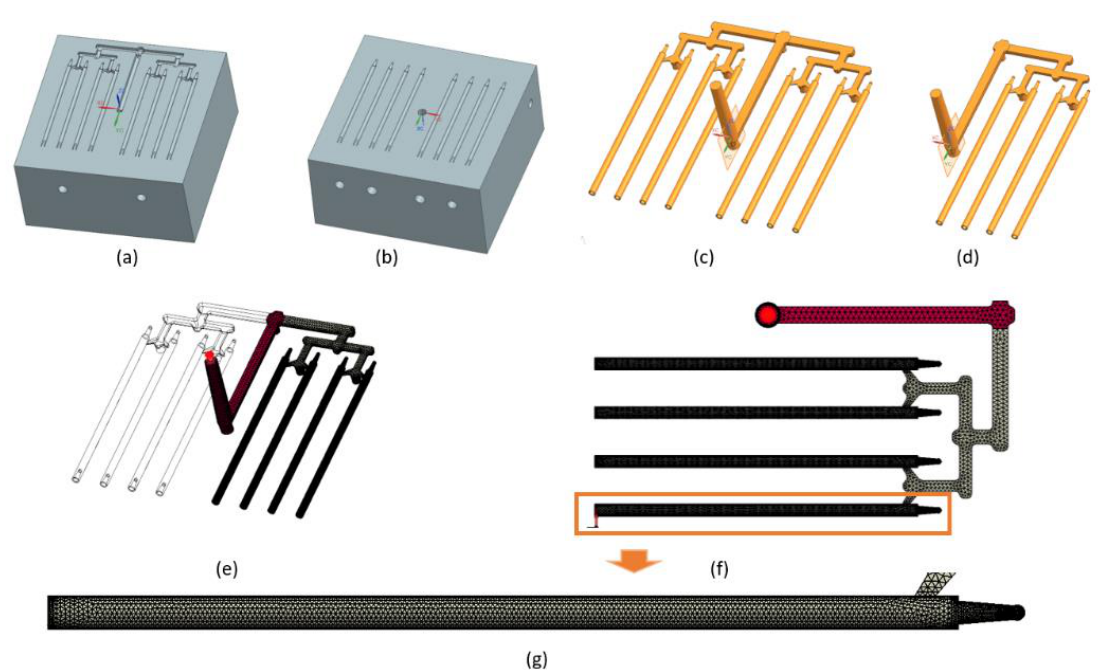
Figure 2. ( a ) The part model; ( b ) injection mold CAD data translucency view; ( c ) injection mold: major CAD data—upper side; ( d ) injection mold: major CAD data—lower side.